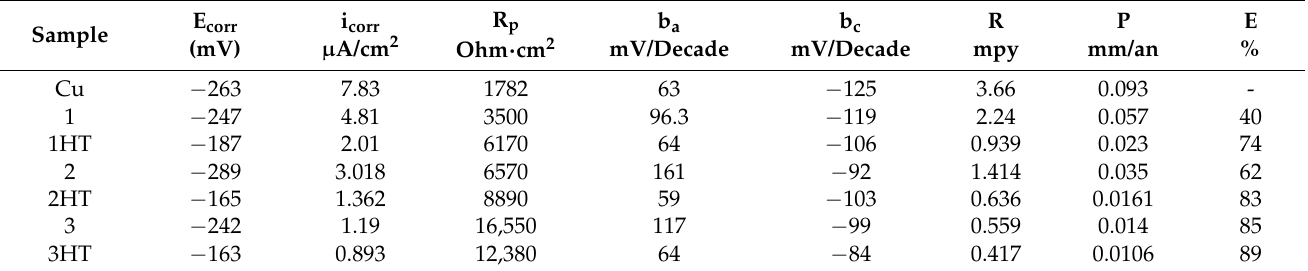
Figure 4. Taffel plots of the studied HEA thin-film electrodeposited and heat-treated samples: ( a ) 1, 1HT; ( b ) 2, 2HT; and ( c ) 3, 3HT. Table 1. Kinetic and corrosion parameters of the uncoated and coated electrodes, as-deposited and heat-treated, in synthetic seawater solution.